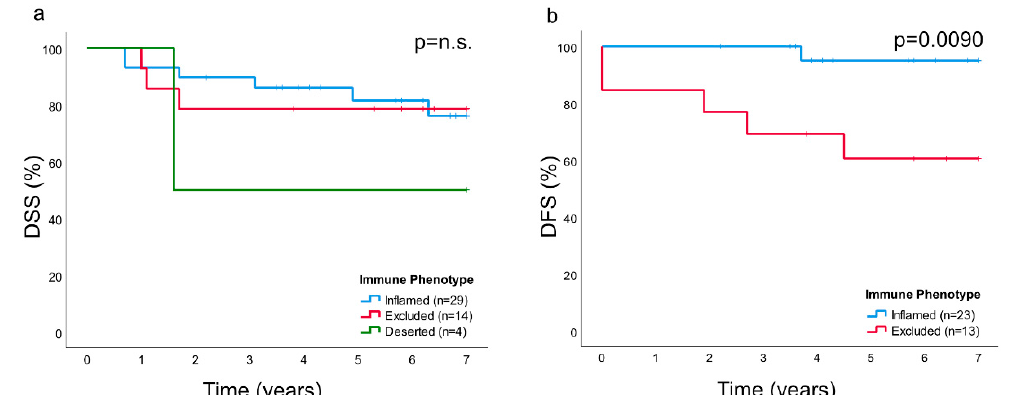
Figure 6. Kaplan–Meier estimates of ( a ) DSS and ( b ) DFS for NPC based on immune phenotypes indicated a better prognosis in terms of DFS for the “inflamed” subtype compared to the “excluded” ( p = 0.0090). Since three out of four patients with immune “deserted” phenotype presented with spread disease, this subset was not included in the DFS analysis. No differences were observed in the DSS analysis. Abbreviation: DSS = disease-specific survival and DFS = disease-free survival.